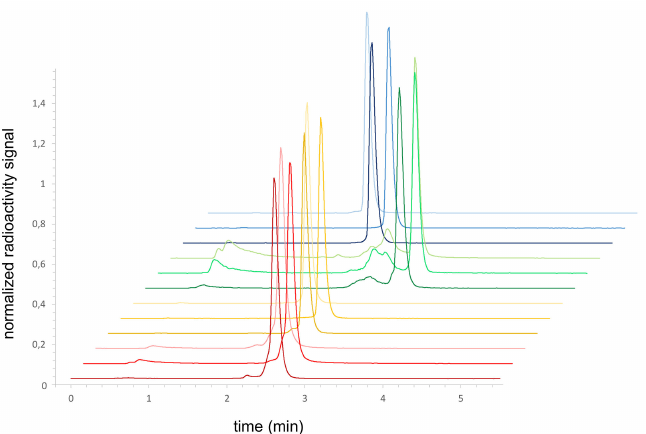
Figure 3. Radio-HPLC chromatograms of the synthesized imaging agents, from front to back: